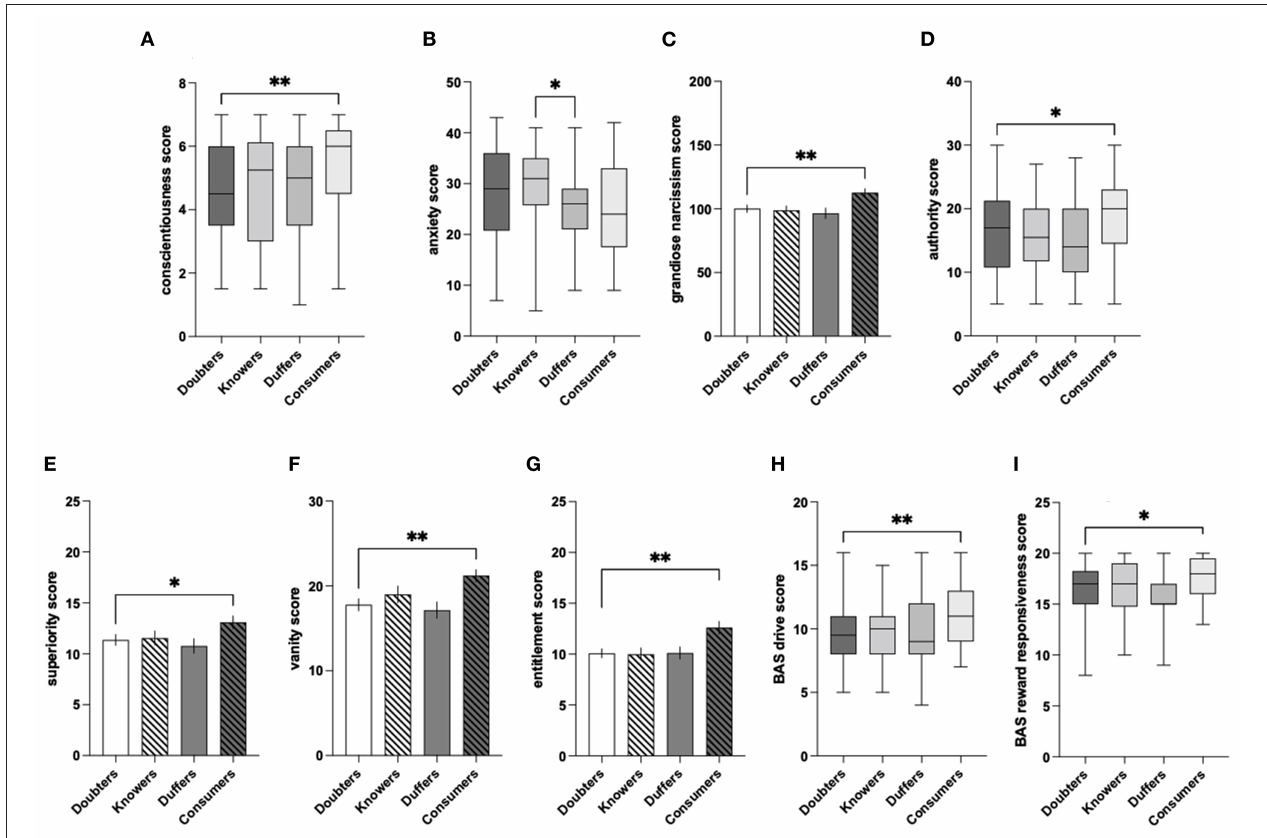
FIGURE 10 | Interphenotypic differences in veracity ratings for (A) conscientiousness; (B) anxiety; (C) grandiose narcissism; (D) authority; (E) superiority; (F) vanity; (G) entitlement; (H) BAS Drive; and (I) BAS reward responsiveness. The data are presented as AVG ± SEM (the bar plots) or median with interquartile range (the box plots). * P ≤ 0.05 ** P ≤